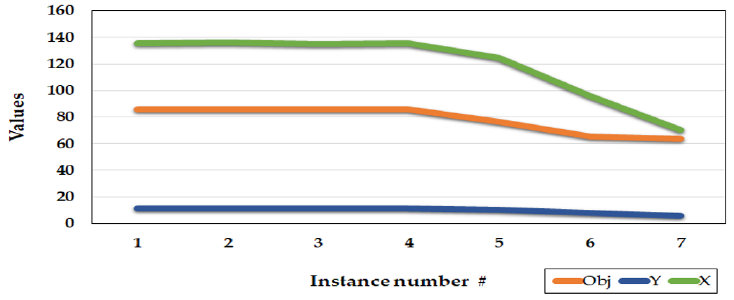
Figure 2. Results of the sensitivity analysis for the capacity of the facilities.